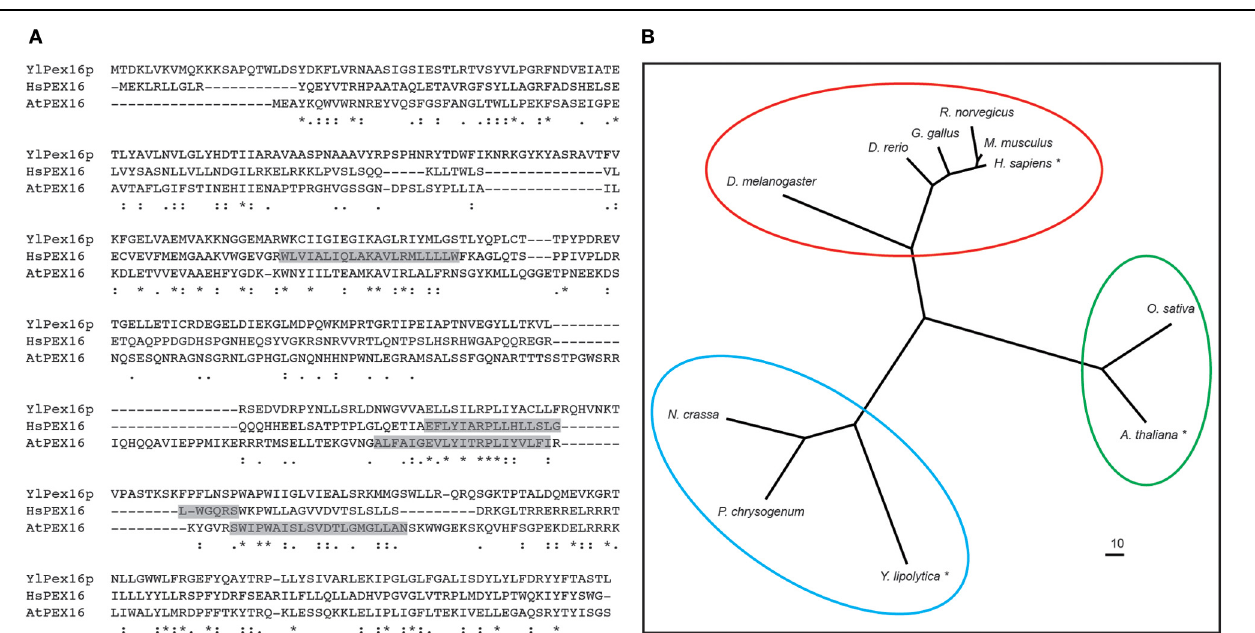
with an asterisk, and circles represent PEX16 proteins of the metazons, yeasts (fungi), and plants that form distinct clades. Branch lengths of the tree are proportional to divergence with the “10” scale bar representing a 10% change. Sequence alignments were carried out using either CLUSTALW (Larkin et al., 2007) and the phlyogram was generated using the program TreeView (v1.6.6). Genbank ® accession numbers are as follows: H. sapiens (BAA88826.1), Rattus norvegicus (NP_001012088.1), Mus musculus (NP_660104.2), Drosophila melanogaster (NP_649252.1), Neurospora crassa (XP_963884.2), Danio rerio (NP_001020340.1), Gallus gallus (XP_421125.3), Penicillium chrysogenum (ABH11422.1), Y. lipolytica (AAB41724.1), A. thaliana (NP_566053.1), Oryza sativa